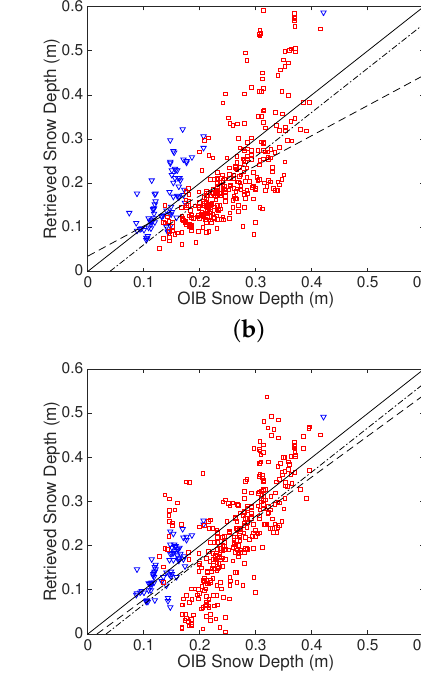
1.5 K of SMOS TB. −